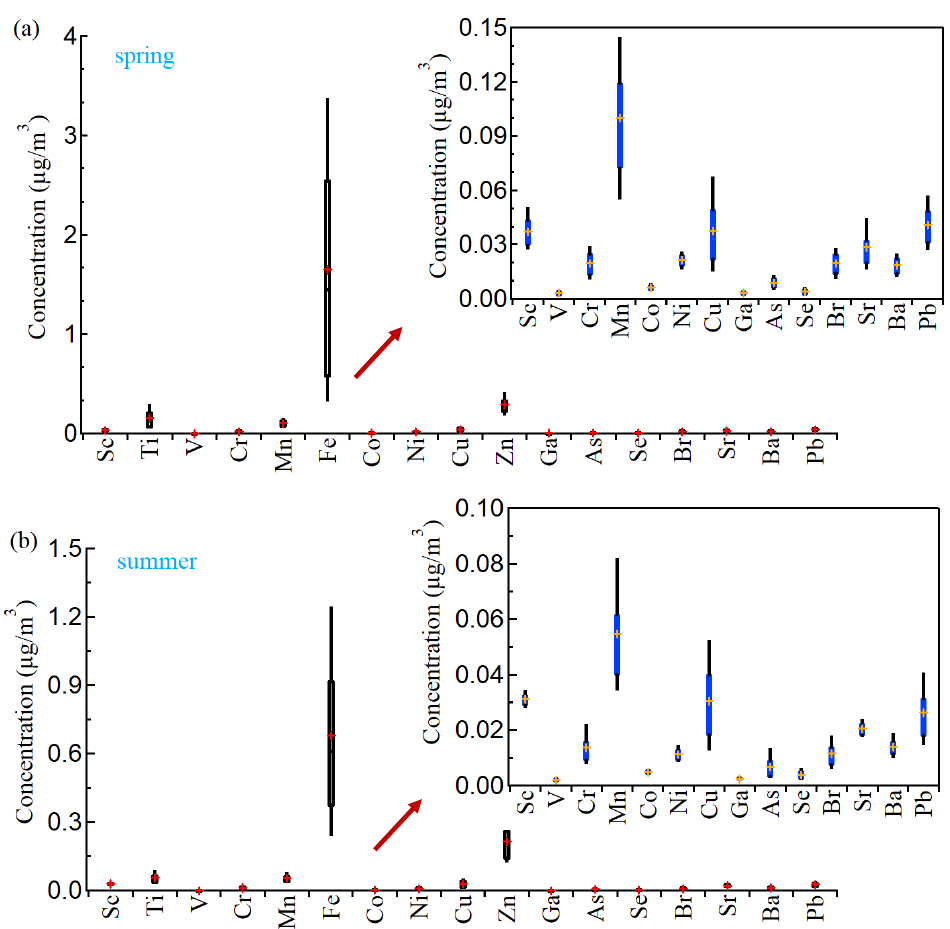
Figure 1. Box plots of daily average mass concentration of trace elements in PM 2.5 in spring and summer. The whiskers above and below the boxes are the 90th and 10th percentiles, the upper lower boundaries of the boxes are the 75th and 25th percentiles, the lines in the boxes represent the median values, and the dots indicate the mean values. ( a ) spring, ( b ) summe.